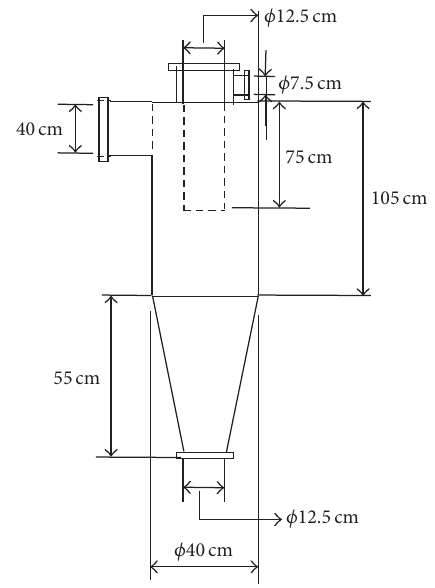
Figure 6: Dimensions of